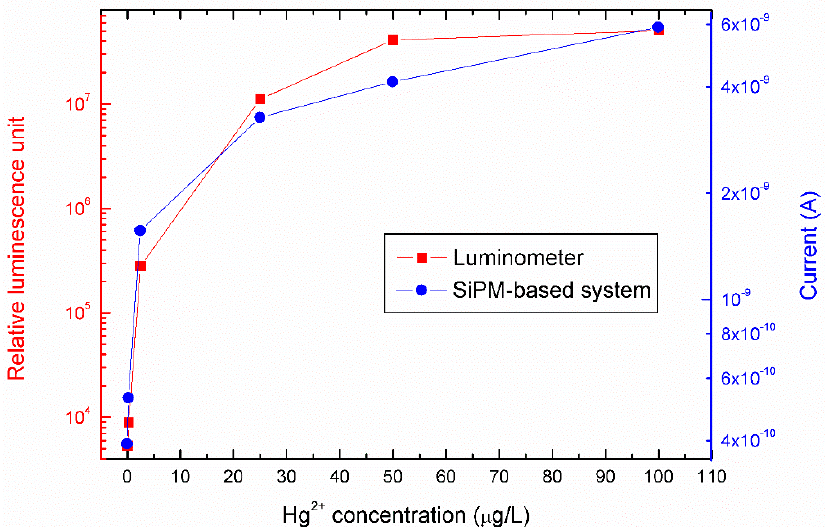
Figure 6 . Data comparison between the mercury-induced bioluminescence output of the E. coli reporter cells measured in the SiPM-based miniaturized system (blue curve, referred to the right axis) and by a conventional luminometer (red curve, referred to the left axis). The SiPM-based system current data were taken at 10 s of acquisition.